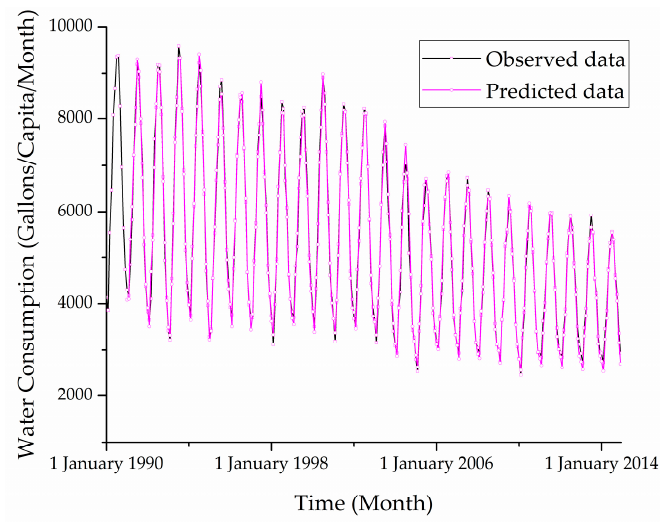
Figure 8. Time-series of monthly water consumption observed and predicted data from 1990 to 2014.